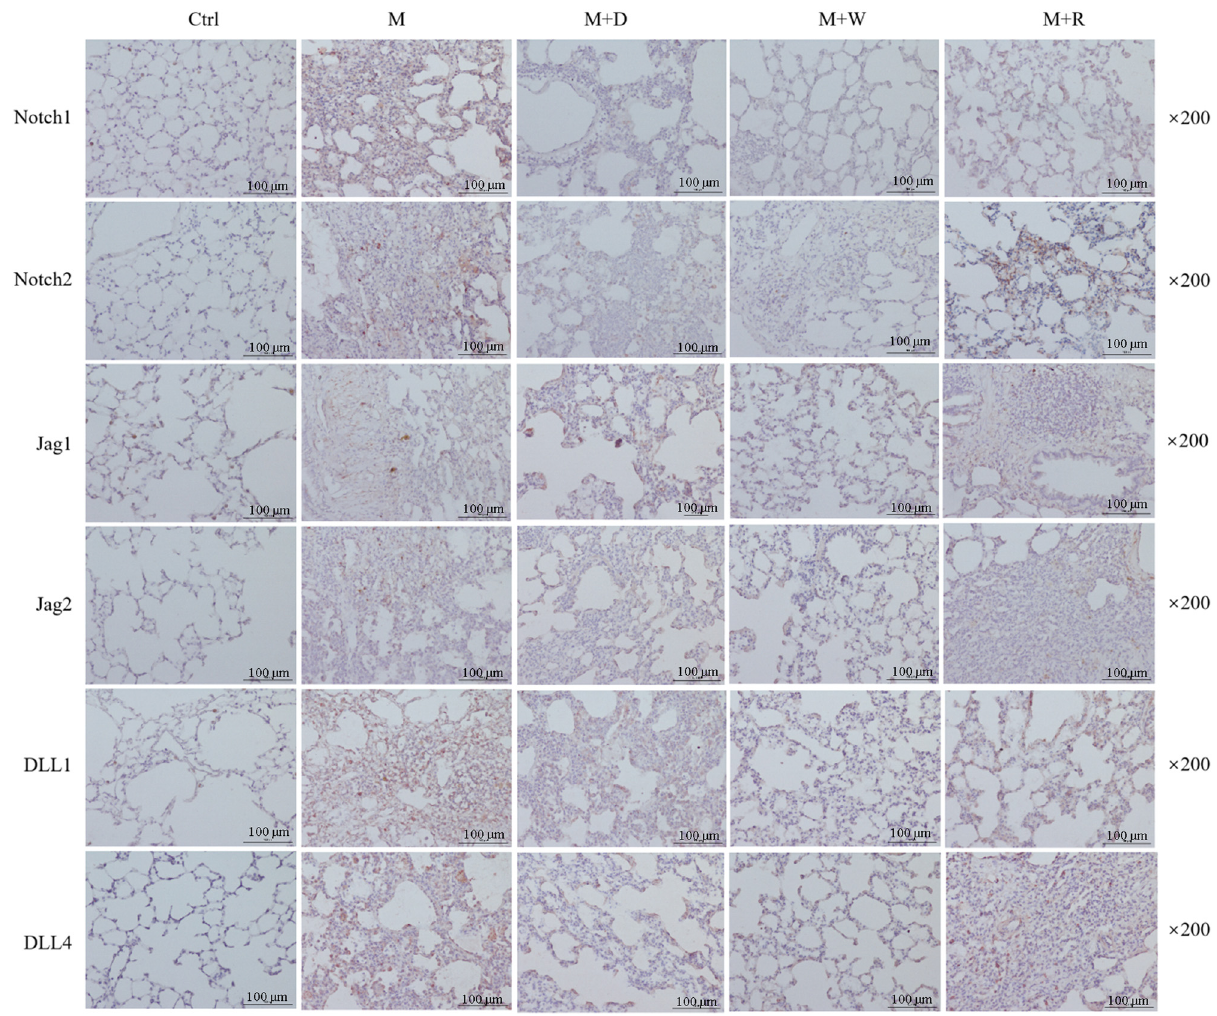
Figure 3: IHC image of key proteins of the Notch pathway in the lung tissues of rats in each group (× 200 )